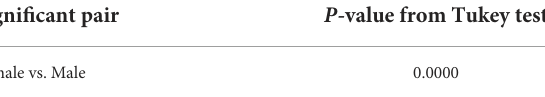
TABLE 11 Significantly different pairs from Tukey test of